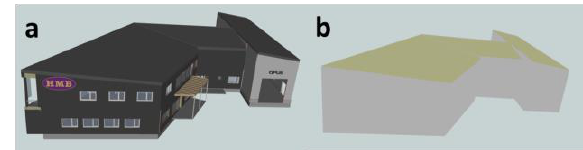
Figure 3. BIM model of Myran (a) and the LOD2 geodata building model